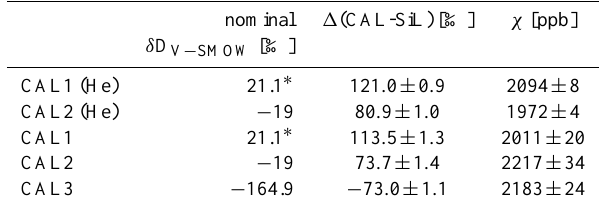
Table 5. Mean measured 1 -differences and derived concentrations for the three air-diluted δ D calibration gases CAL1 to CAL3 and the two He-diluted gases evaluated with the SPI-Software. Errors denote the 1. σ standard deviation.